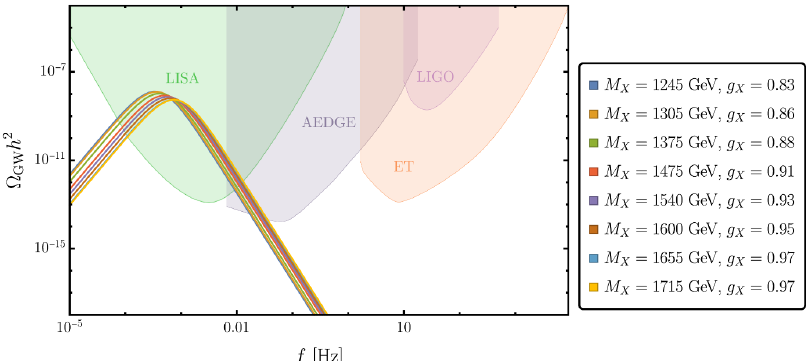
Figure 18 . Predictions for spectra of gravitational waves together with integrated sensitivity curves for LISA, AEDGE, ET and LIGO for the points in the parameter space where DM relic abundance is